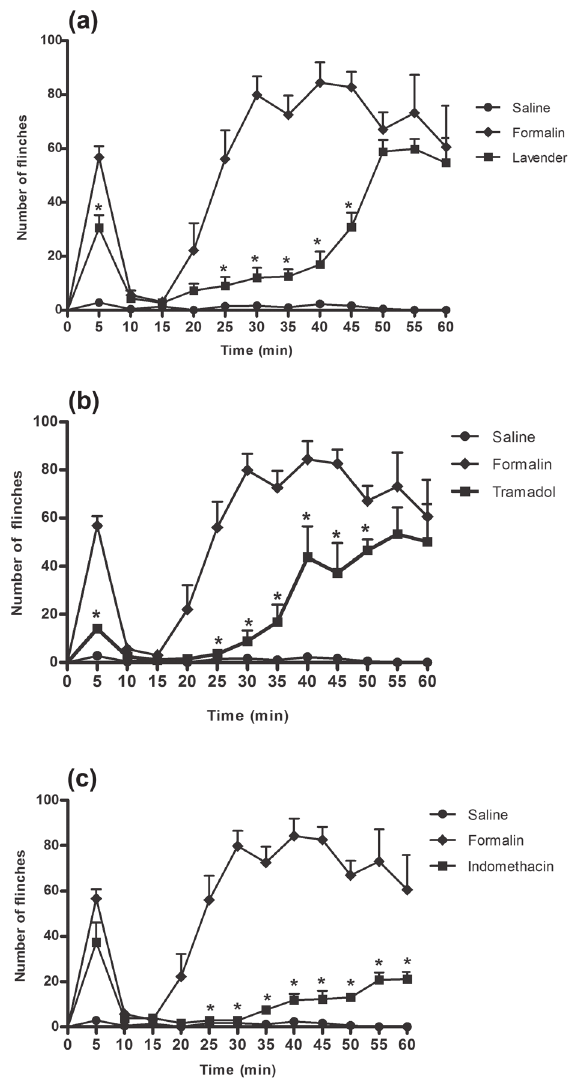
Figure 3 - Comparison of topical and oral anti-inflammatory effects of lavender essential oil in croton oil-induced ear edema. C = control group (mice not treated); VC = vehicle control group (mice treated with DMSO p.o.); LEO p.o. = mice treated with lavender essential oil 0.6 g/kg p.o.; LEO topic = mice treated with lavender essential oil topically 50 μL/ ear; DEXA = mice treated with dexamethasone 0.5 mg/kg s.c. Values represent the mean ± SEM. * p < 0.05 vs. control group (C) and vehicle control group (VC).